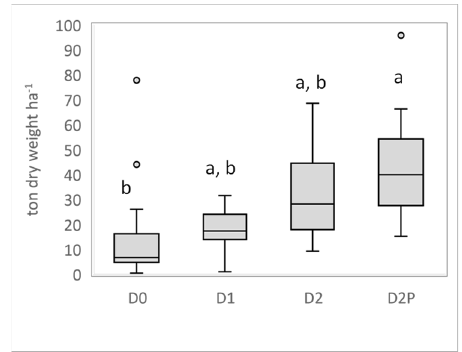
Figure 4. Comparison of the yield measured at the end of the growing season in 2020. Different letters above box plots indicate significant differences at p < 0.05. The horizontal line inside each box-whisker represents the median, vertical small rectangles represent interquartile ranges, and circles are